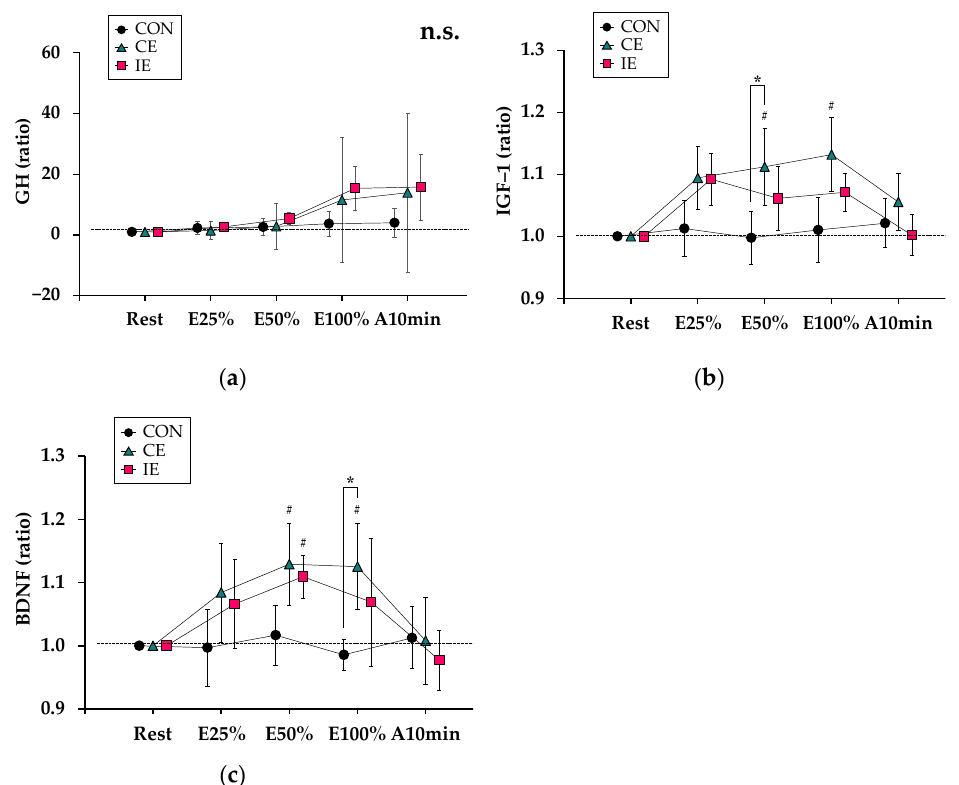
Figure 4. Responses of variables related to myotrophic and neurotrophic hormones: Relative changes of ( a ) growth hormone (GH), ( b ) insulin–like growth factor (IGF) –1, and ( c ) brain–derived neurotrophic factor (BDNF) are shown. The circle, triangle, and cube indicate control (CON), continuous exercise (CE), and intermittent exercise (IE) values relative to those at Rest, respectively. *: p < 0.05 indicates [type]. #: p < 0.05 indicates [time] with Rest.